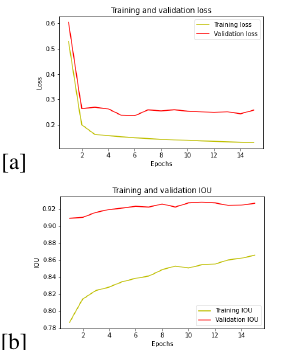
Figure 5. (a) shows the progression of training and validation loss and (b) shows the progression of training and validation IoU, for the FPN model with Efficient B7 as encoder, over 15 epochs.